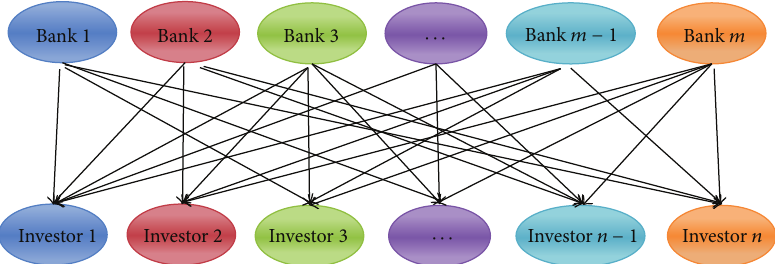
Figure 1: A tiered structure network of credit risk transfer with multi-origin-destination in CRT